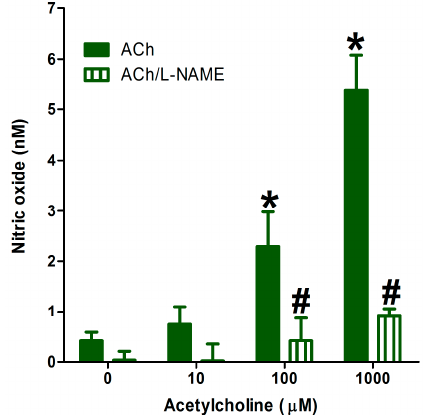
Figure 4. Effect of the addition of cumulative concentrations of ACh on NO generation from isolated aortae in absence or presence of N ω -Nitro- L -arginine methyl ester ( L -NAME, 300 µM). Values shown represent the mean ± SEM for four independent replicate experiments. * Significantly different from NO generation before ACh addition at p < 0.05. # Significantly different from NO generation at the corresponding ACh concentration at p < 0.05 by two-way ANOVA followed by Bonferroni post hoc test.